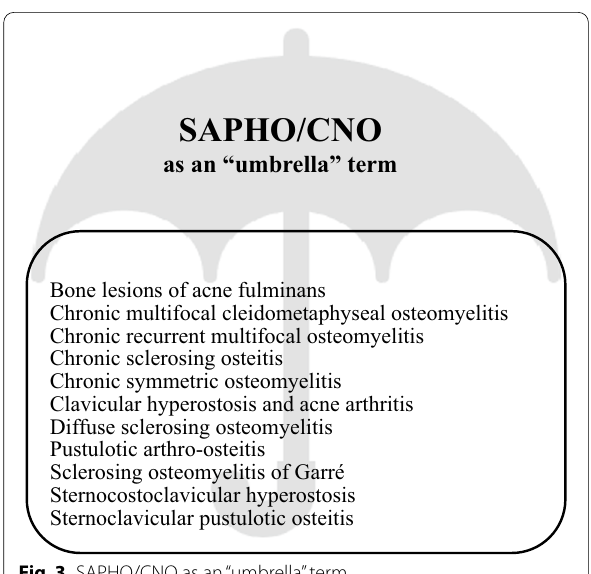
Bone lesions of acne fulminans Chronic multifocal cleidometaphyseal osteomyelitis Chronic recurrent multifocal osteomyelitis Chronic sclerosing osteitis Chronic symmetric osteomyelitis Clavicular hyperostosis and acne arthritis Diffuse sclerosing osteomyelitis Pustulotic arthro-osteitis Sclerosing osteomyelitis of Garré Sternocostoclavicular hyperostosis Sternoclavicular pustulotic osteitis Fig. 3 SAPHO/CNO as an “umbrella”